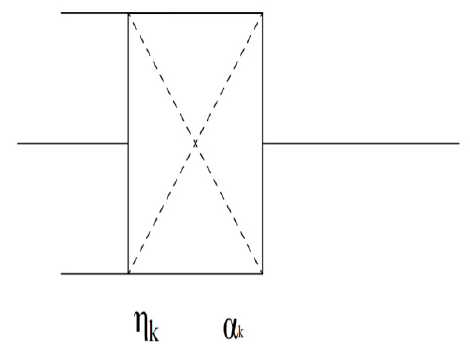
Figure 8. The variable-order fractional Abel dashpot.